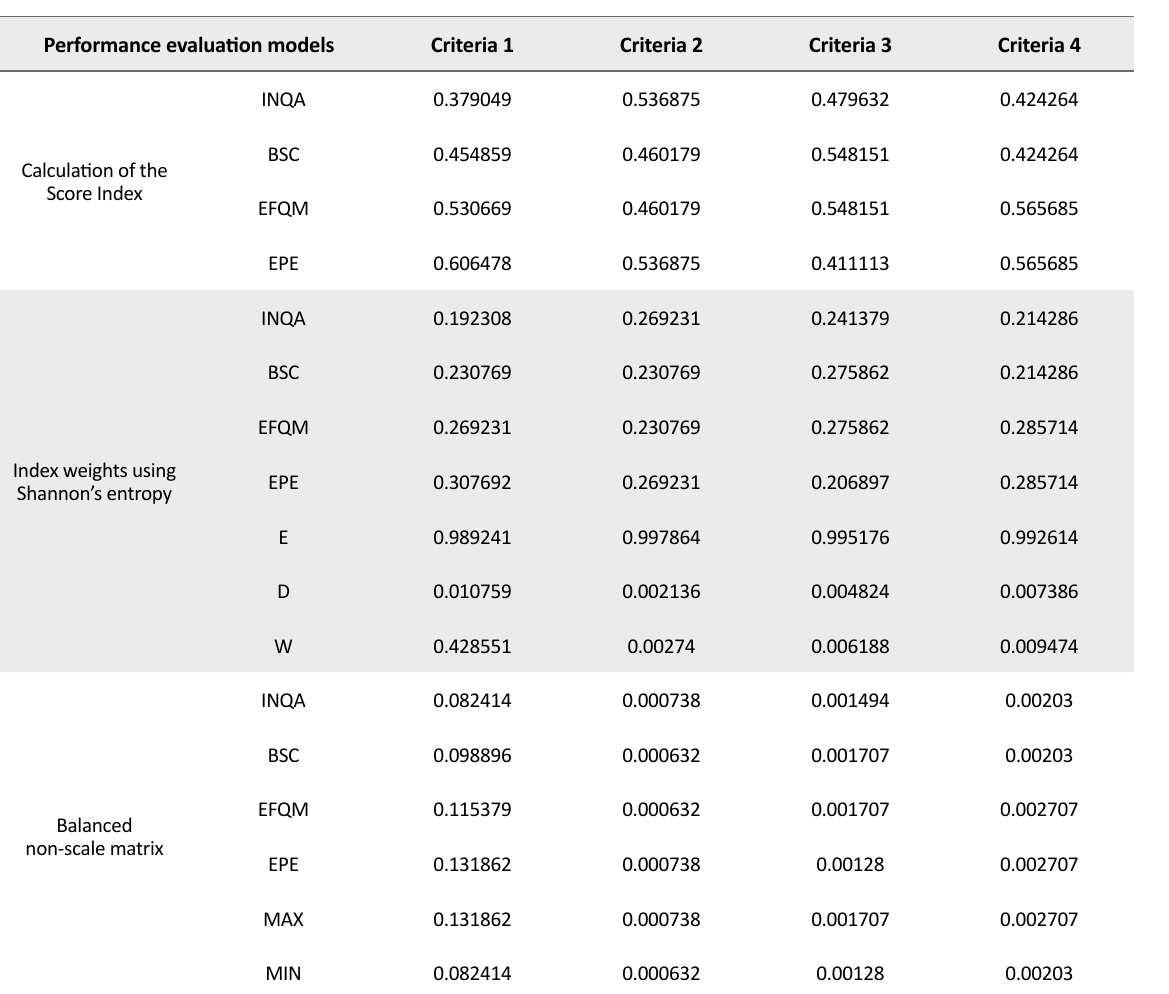
Table 5. The prioritization of an organization’s EPE models based on TOPSIS Performance evaluation